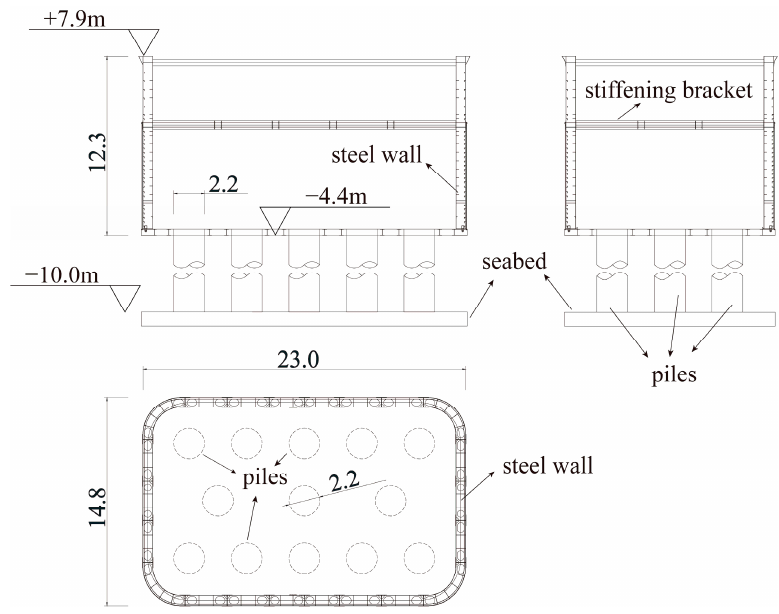
Figure 2. Cross-sections of the cofferdam.